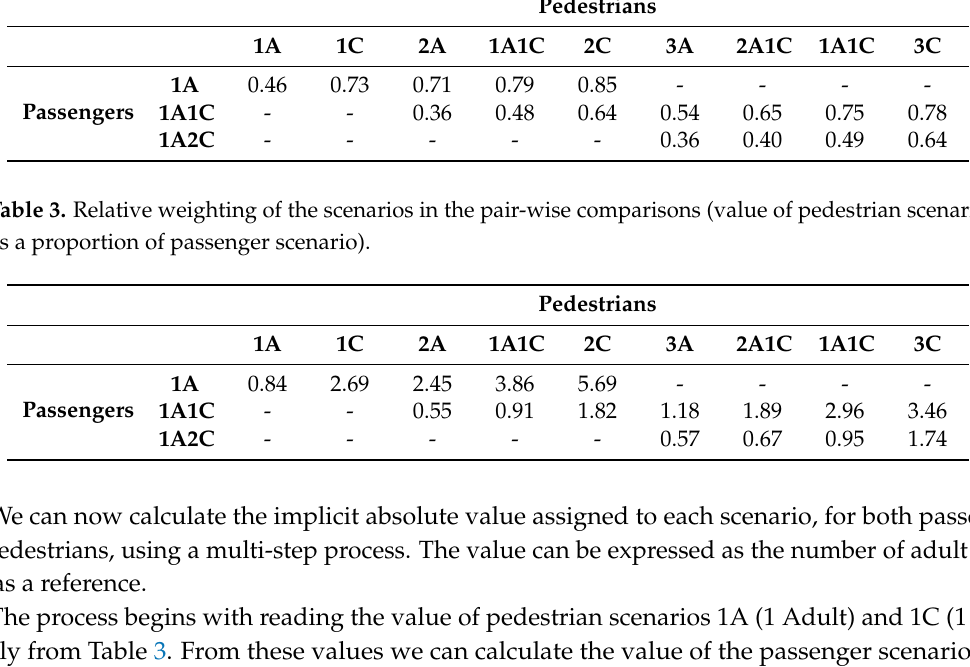
Table 2. Percentage of respondents selecting to sacrifice passengers by scenario (A = Adult, C = Child).